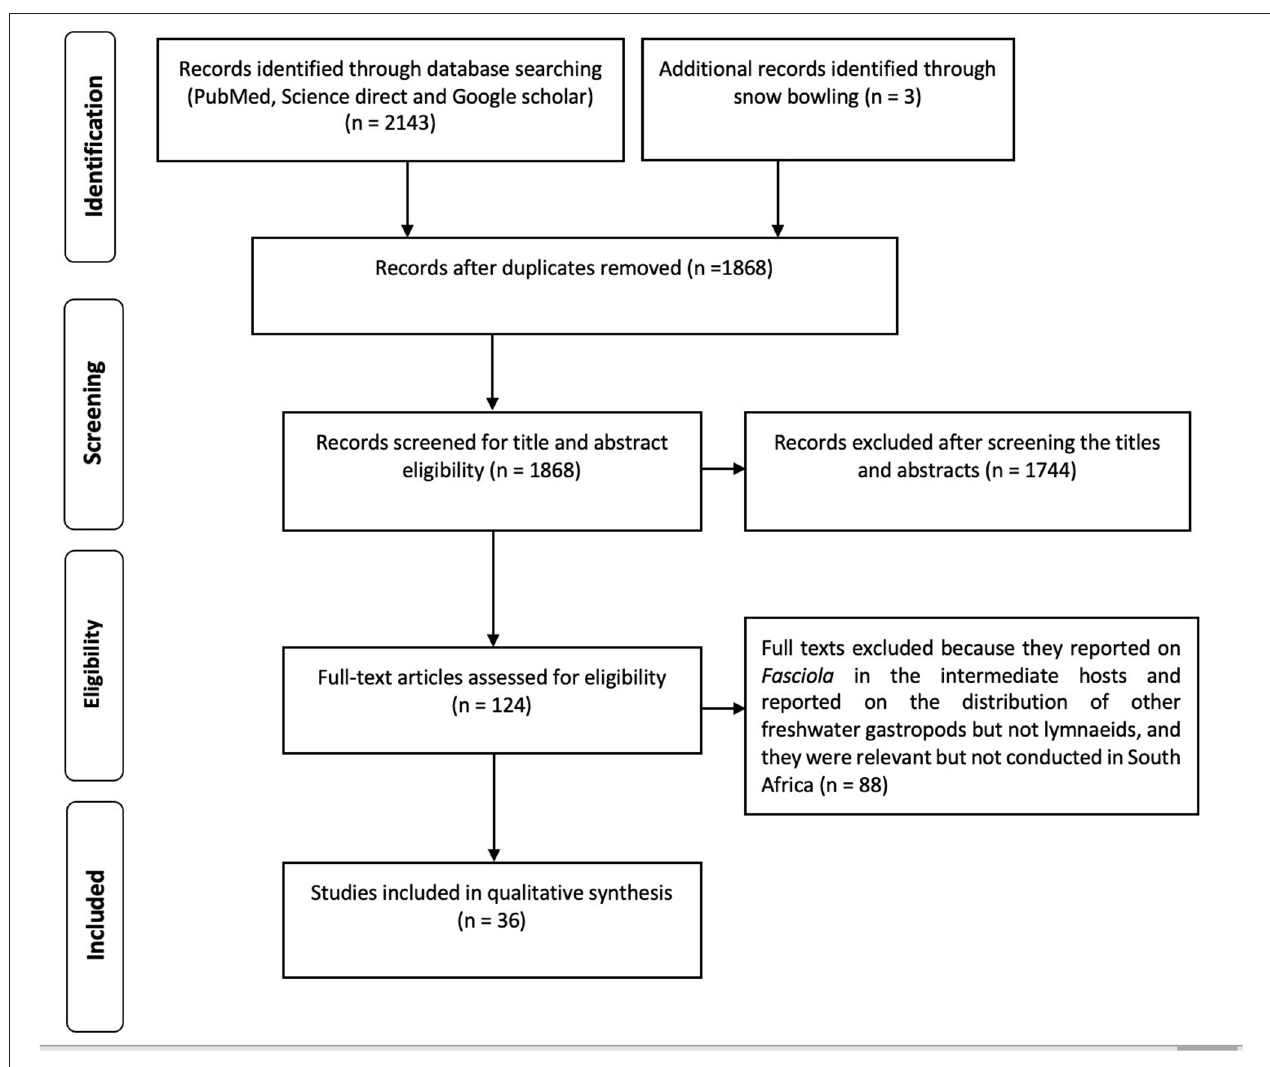
FIGURE 1 | Search flow and selection